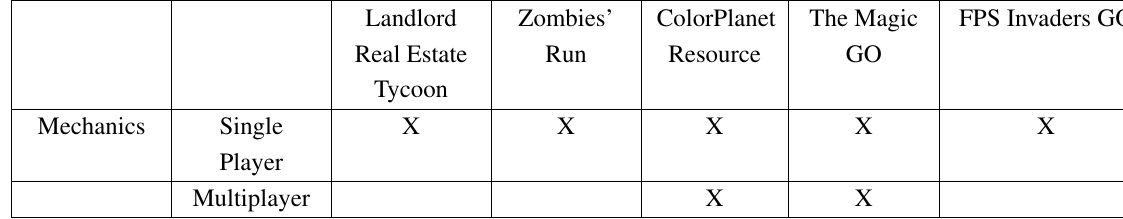
Table 4. Breakdown for RPG